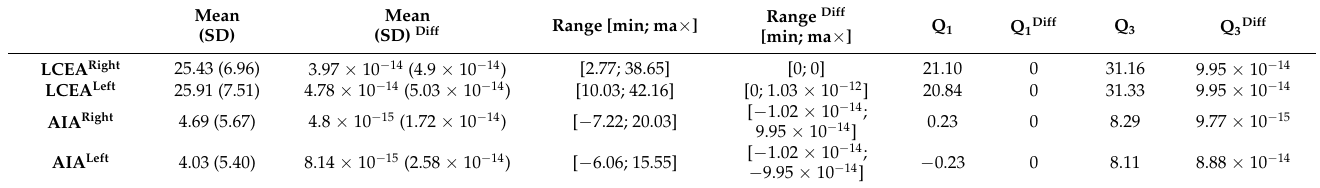
Table 1. First read by algorithm (mean, SD, range, 1st and 3rd percentiles) and differences (Diff) between 1st and 2nd algorithm read. (n = 71).